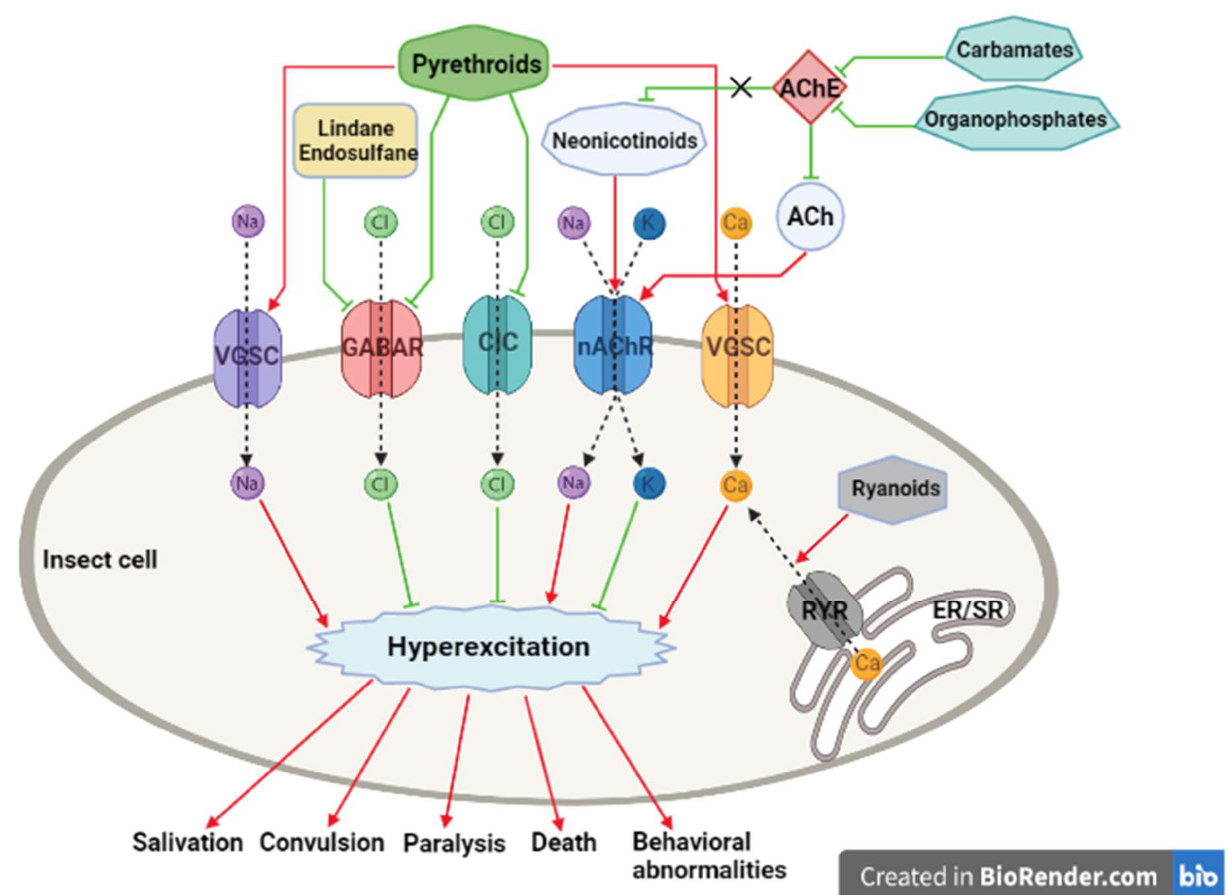
Figure 1. Molecular actions of different classes of insecticides on ion channels. In normal conditions, the alternation of activation and inhibition of ion channels are essential in neurotransmission. Any external factor which upsets this balance prevent the formation of normal membrane potentials, which leads to unconventional neurotransmission (e.g., hyperexcitation of cells). The induced irregular neurotransmission may produce different symptoms (e.g., convulsions, paralysis) and even lead to death. (Abbreviations: GABA = γ-aminobutyric acid, Ach = acetylcholine, AChE = acetylcholinesterase, RyR = Ryanodine receptor, VGSC = voltage-gated sodium channel, GABAR = GABA receptor, nAChR = nicotinic acetylcholine receptor, Na = sodium ion, Cl = chloride ion, K = potassium ion, Ca = calcium ion).